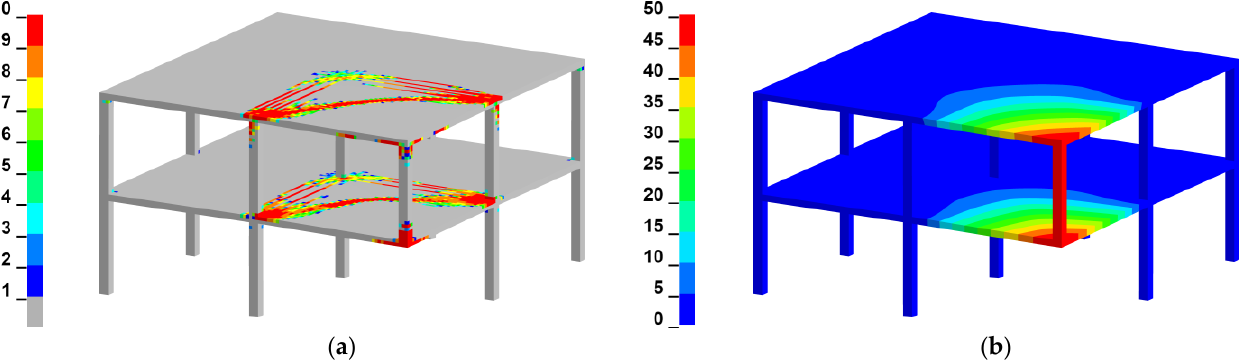
Figure 11. The state of maximum displacements after corner column removal: ( a ) — damage; ( b ) — vertical displacements, mm.